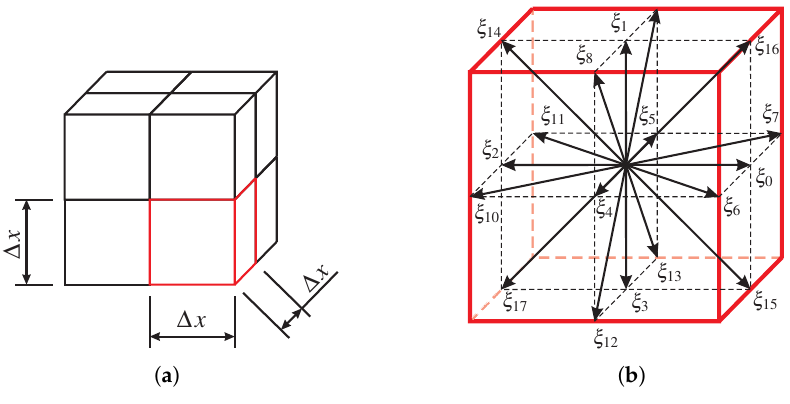
Figure 3. Spatial discretization ( a ) and model D3Q19 of velocity discretization ( b )